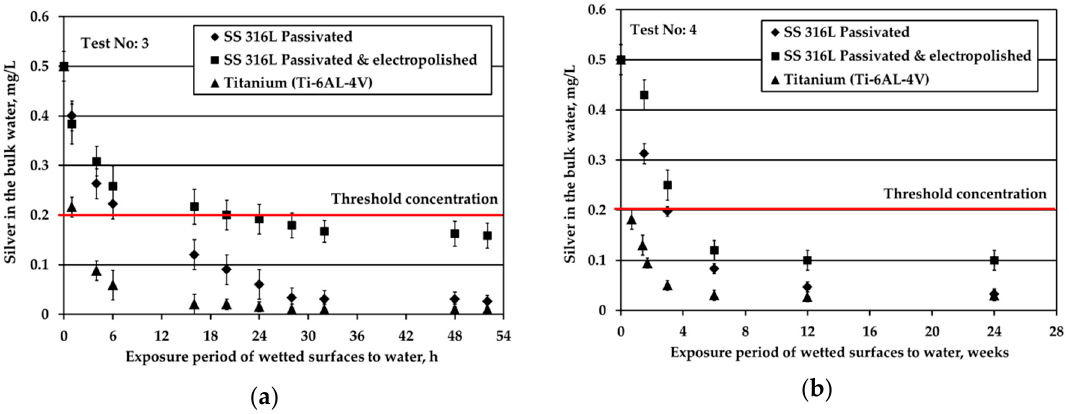
Figure 2. Silver loss from the bulk water (initial Ag concentration: 0.5 mg/L) for all three examined materials under nitrogen headspace and stagnant conditions for S/V equal to: ( a ) 1.0 cm − 1 ; ( b ) 0.1 cm − 1 .